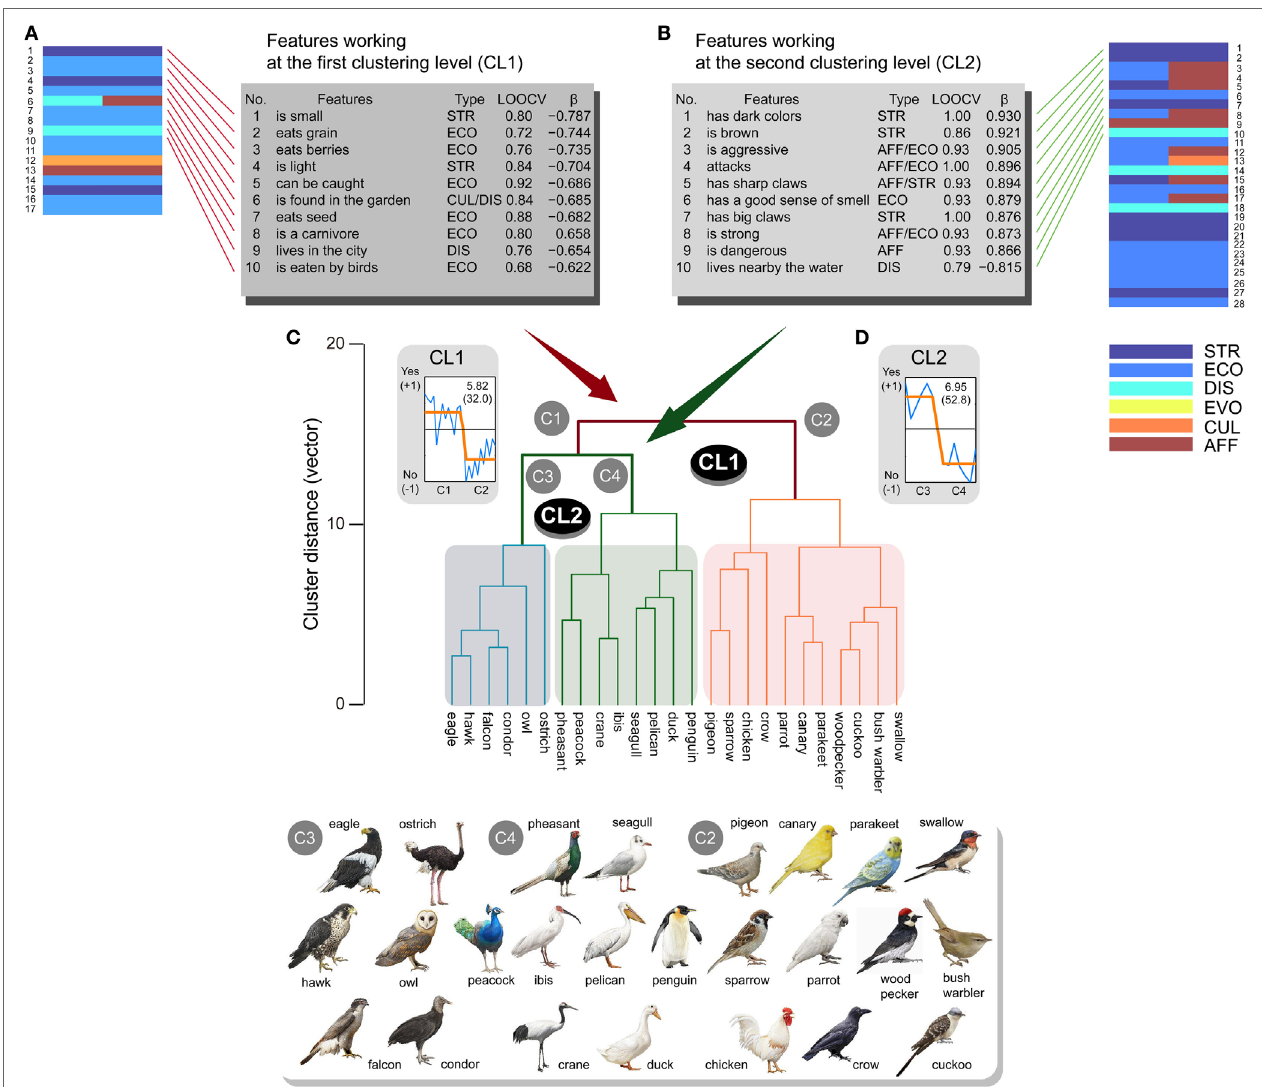
FigUre 4 | Sub-ordinate animal classification ( n = 25) for the bird class and related features ranked within the top 10. Animals were separated into two major clusters (C1, C2) at the first clustering level (CL1). The first cluster (C1) was separated into two clusters (C3, C4) at the second clustering level (CL2). Features ranked within the top 10 are listed for CL1 (a) and CL2 (B) (STR, structural; ECO, ecological; DIS, distributional; EVO, evolutional; CUL, cultural; AFF, affective) from significant features plotted by brick charts. These features possessed high classification accuracies in leave-one-out cross-validation (LOOCV) tests and good fitting properties ( β ) to sigmoid-shaped binary responses for CL1 (c) and CL2 (D) , respectively. Higher scores on the LOOCVs indicate higher classification accuracy, and more positive and larger β coefficients represent better fitting properties. All the illustrations of animals are copyrighted by M/Y/D/S Graphics (Yokohama, Japan), which permitted us to reproduce all illustrations in the